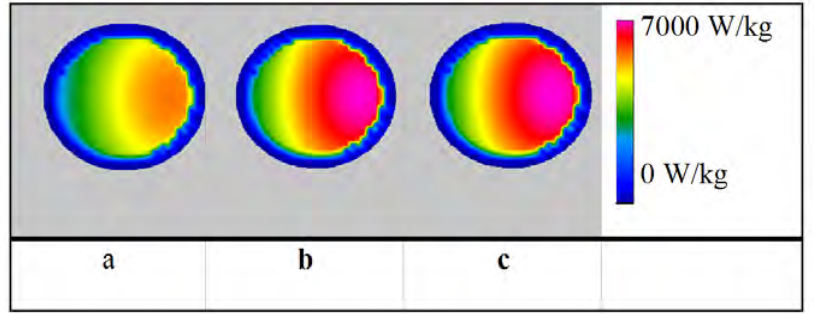
Figure 3. SAR in the mid section of the reaction vessel centrally positioned in the single mode applicator (300W forward